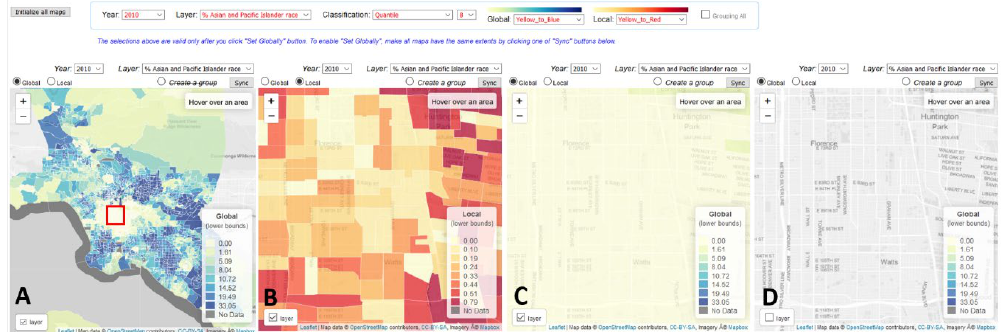
Figure 6. One of the views of ACM. Various views can be created by using options at the top of each map. Maps show the percentage of Asians and Pacific Islanders in the Los Angeles metropolitan area in 2010. The area within the little box at the center of the first map ( A ) is the same area of the other three maps ( B , C , D ). The “Local” radio button is clicked on map ( B ), while the “Global” radio button is clicked on the rest of it.